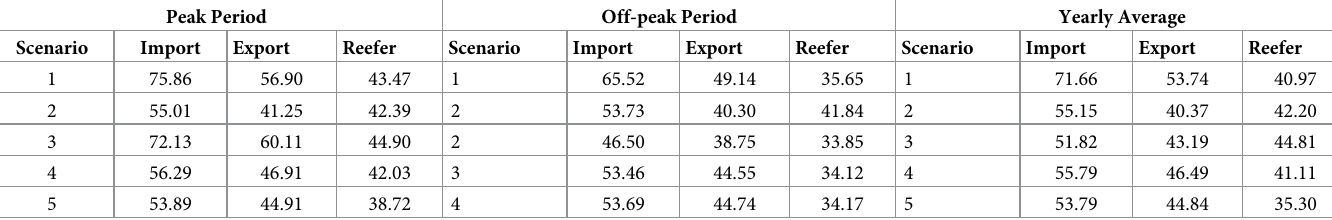
Table 13. Average time that each container type spends at the LICD in scenarios S1–S5 (hours). Peak